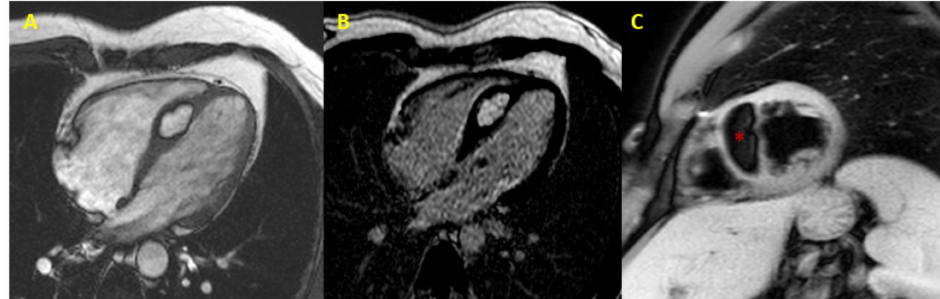
Figure 3. Cardiac lipoma at CMR. CMR image (4-chamber view) showing septal hypertrophy characterized by hyperintense signal in SSFP and LGE sequences (Panel ( A , B )), and signal suppres- sion (* asterisk in Panel ( C )) in fat-saturated images (CMR = cardiac magnetic resonance; SSFP = steady-state free precession; LGE = late gadolinium